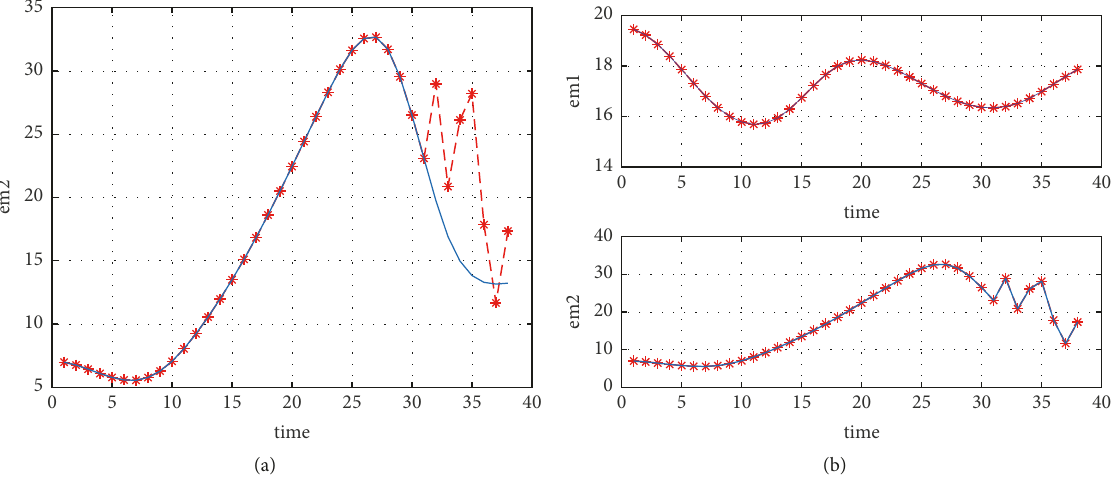
Figure 10: Step fault in IEMG2 signal. (a) Healthy and faulty IEMG signal. (b) Real and estimated faulty input.